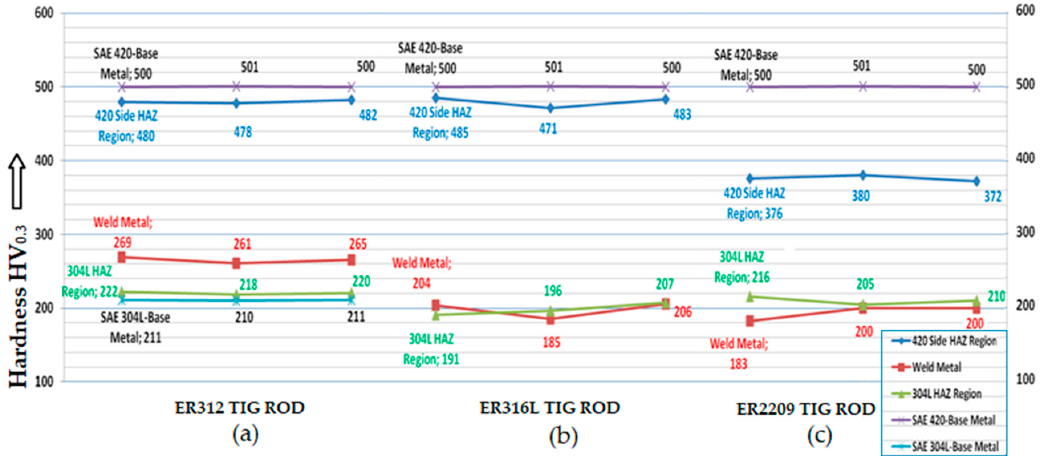
Figure 12. The effect of TIG rod type on microhardness values of weld zones. Samples welded by ( a ) ER312; ( b ) ER316L; ( c ) ER2209 TIG Rods.